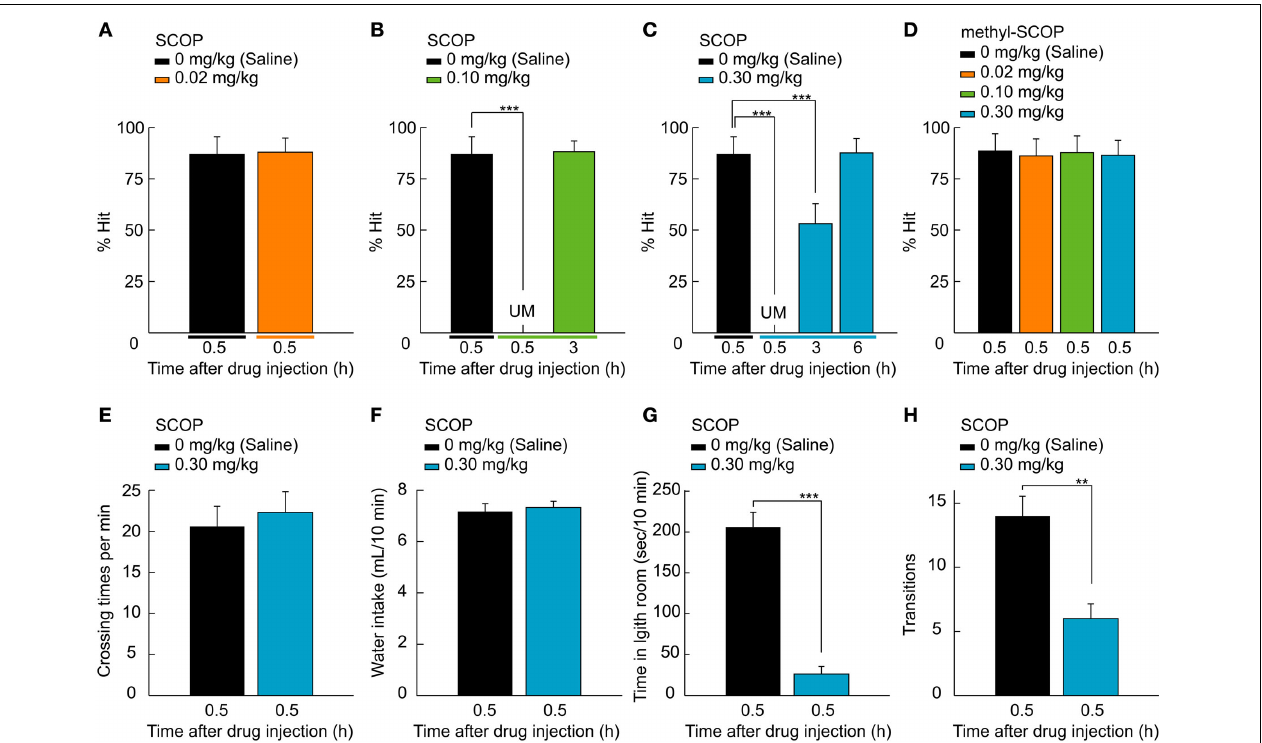
FIGURE 2 | SCOP-induced temporary blackout of well-trained memory. (A–D) Rat performance tested after the injection of saline and various doses of SCOP or methyl-SCOP (0.02, 0.1, and 0.3mg/kg). Rats never manipulated the lever 0.5h after 0.10 or 0.30mg/kg SCOP administration, as behavioral performance was unmeasurable ( UM; B,C) . In contrast, 0.02mg/kg SCOP and all doses of methyl-SCOP did not affect performance (A,D) . At 3h after SCOP injection, rats remembered